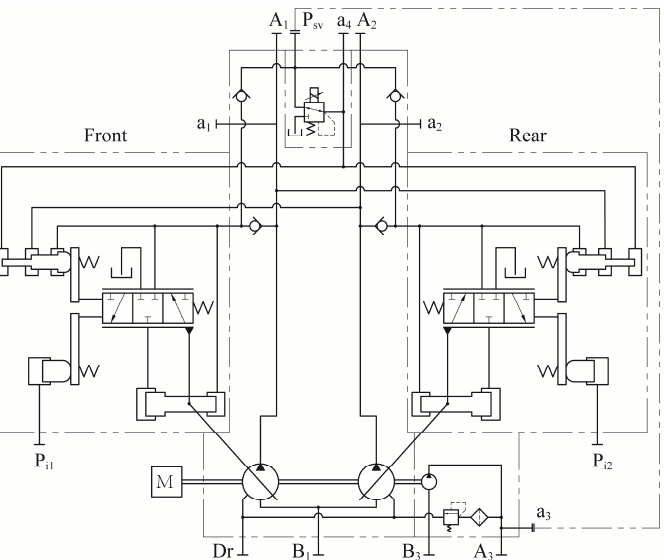
Figure 1. Principle diagram of the hydraulic system for the double-compound axial piston pump.